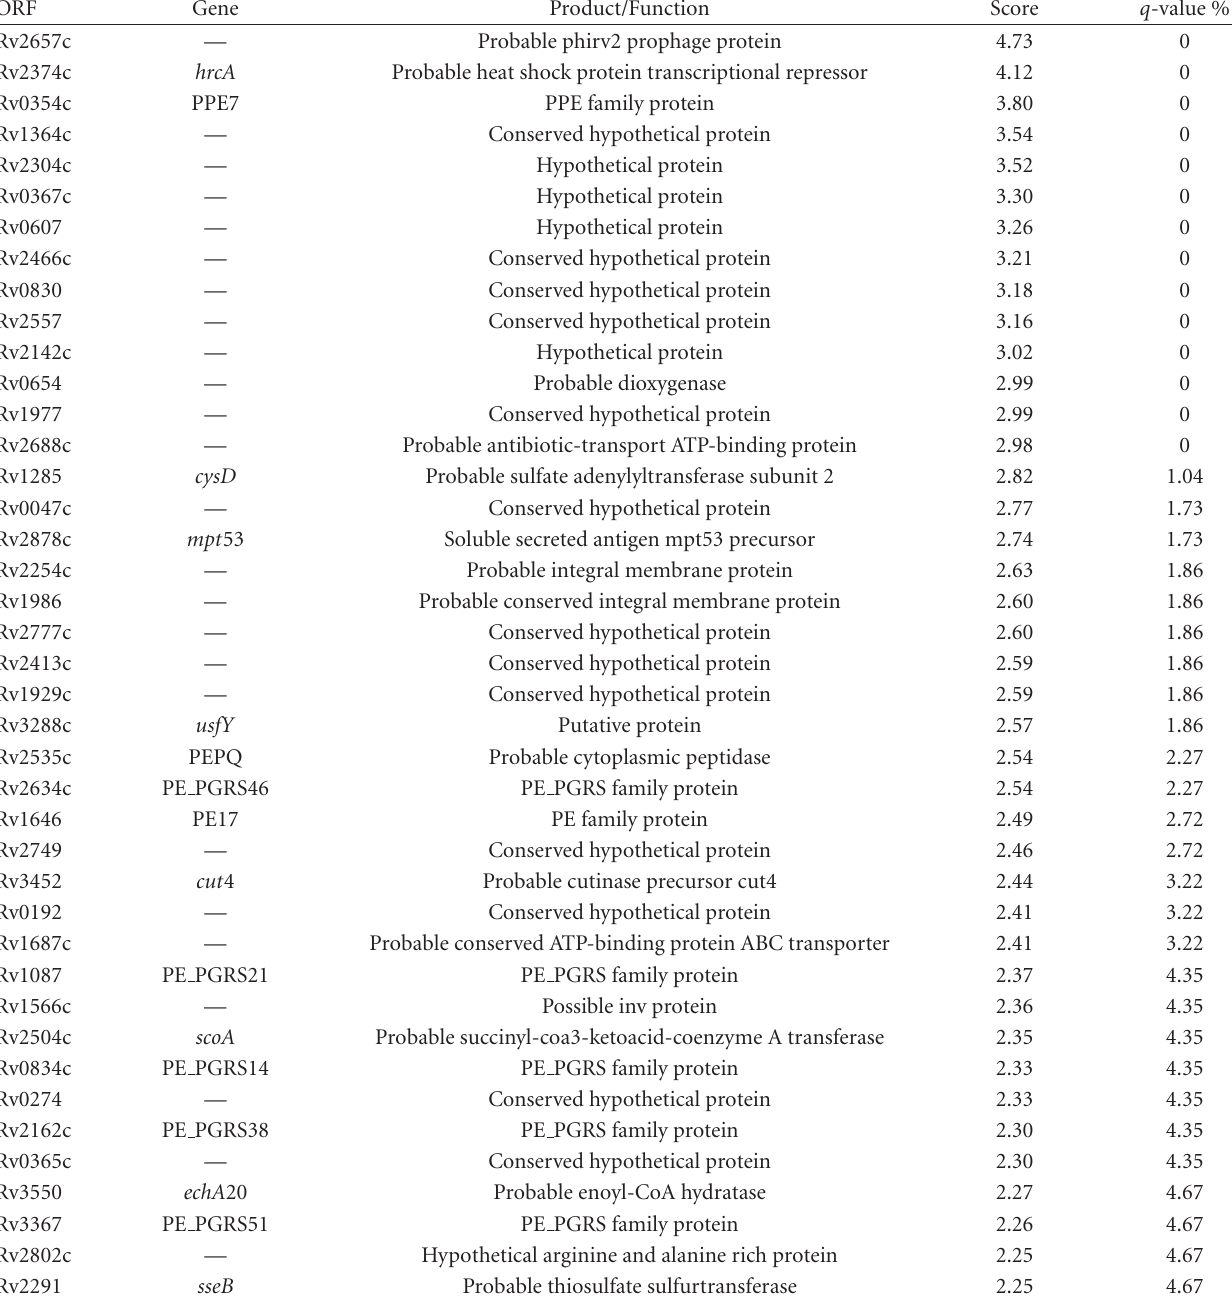
Table 1: Genes di ff erentially induced in response to capreomycin and PA-824 relative to other drugs.